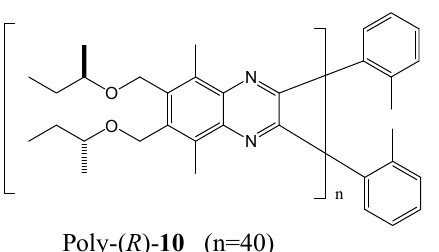
Figure 15. Structure of poly-( R )- 10 in [71].